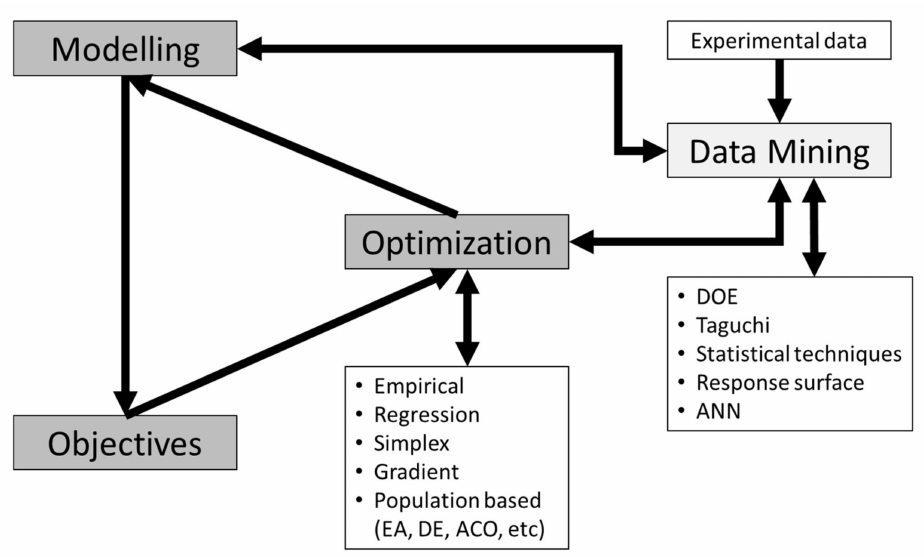
Figure 1. Optimization-based design